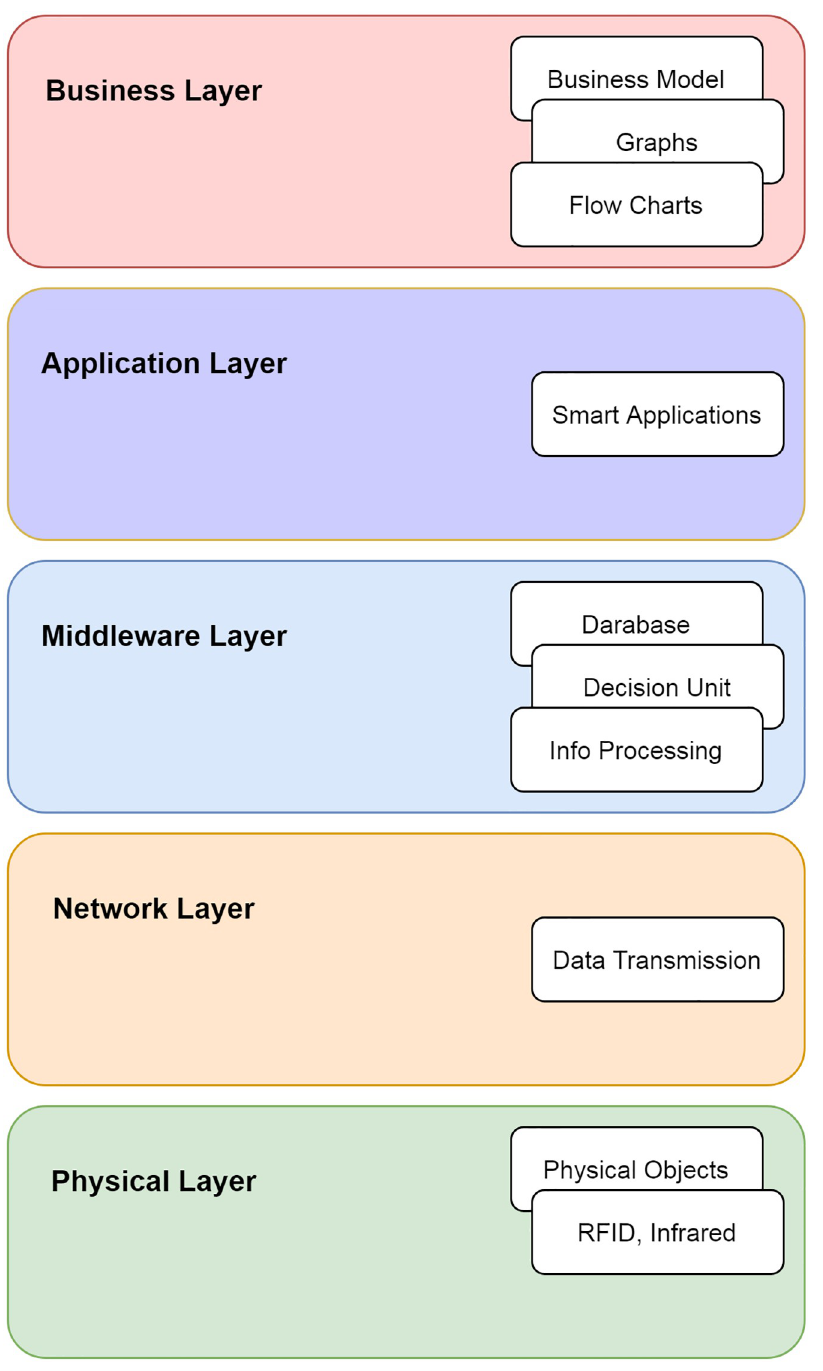
Fig 11. The proposed THC-RPL